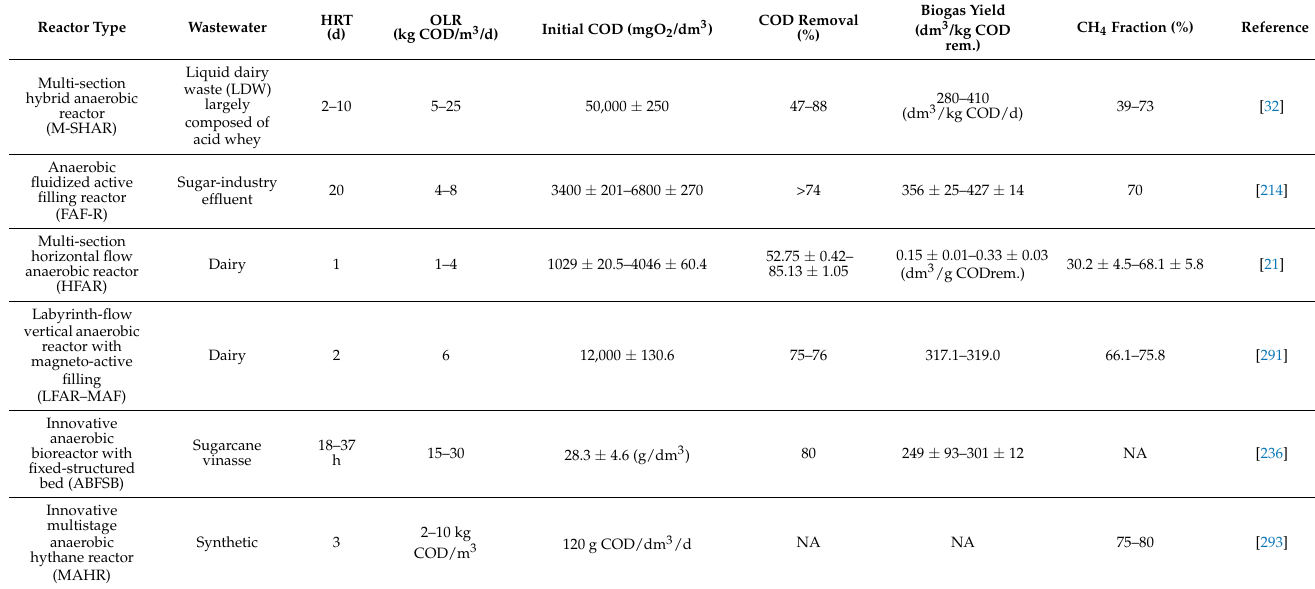
Table 9. Performance of unconventional and innovative anaerobic reactor